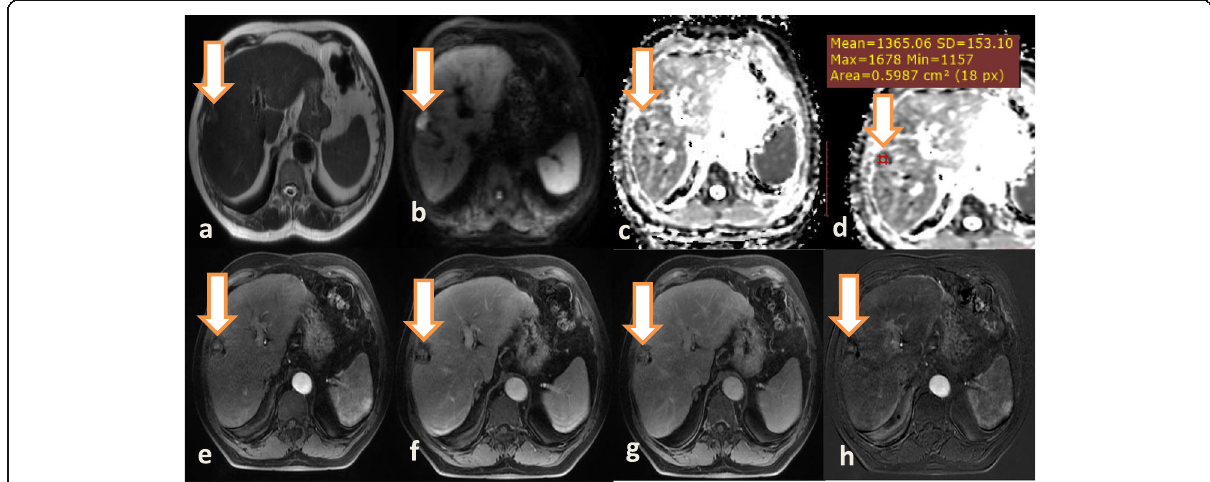
Fig. 3 2nd follow-up after 3 months for a 69-year-old male patient having HCC underwent TACE ablation for one focal lesion involving right hepatic lobe segment V. a Heterogeneous signals (predominantly bright) in T2 WIs. b Restricted diffusion in DWI at 800 b value. c Corresponding dark signals in ADC mapping series. d ADC value = 1.36 × 10 − 3 s/mm 2 increased ADC value in comparison to the 1st follow-up. e Late arterial, f porto-venous, and g delayed phases. h Late arterial subtraction images. Small area of progressive enhancement along the posterior portion of the hepatic observation representing granulation tissue (expected post TACE response). Final diagnosis: LR-TR